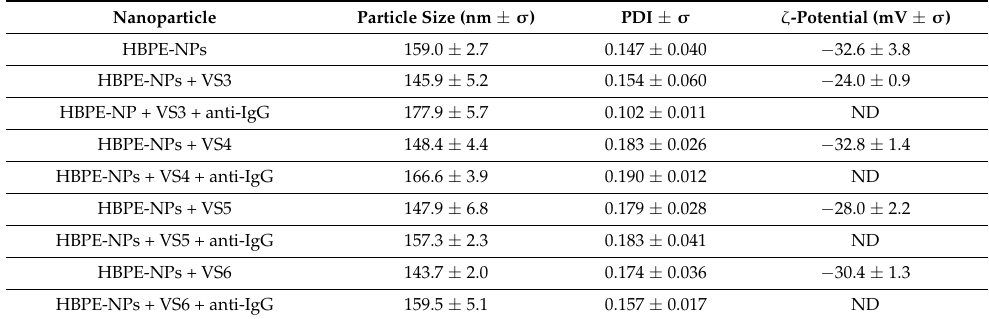
Values represent an average of three replicates. Abbreviations: VS, viral sera collected from IAV-infected mice, numbers refer to the day of sera collection post-infection; PDI, polydispersity index, anti-IgG, anti-IgG antibody, ND, not